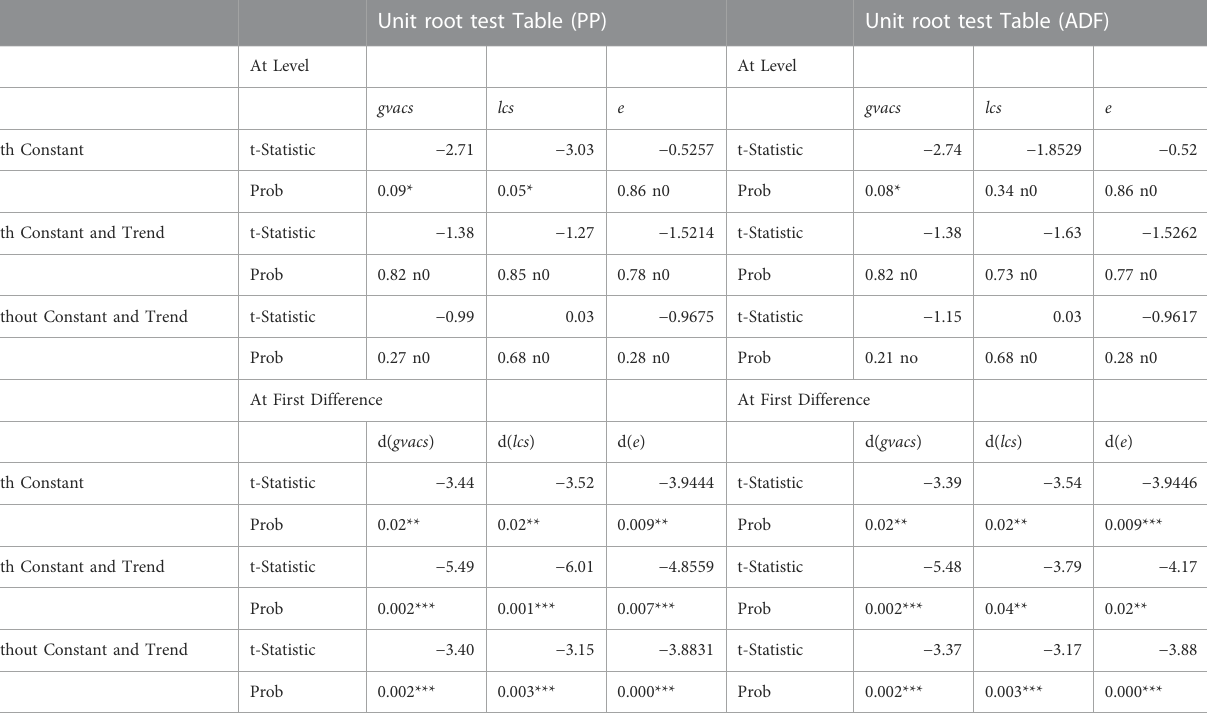
TABLE 2 ADF and PP test results for Unit Root. Unit root test Table (PP) Unit root test Table